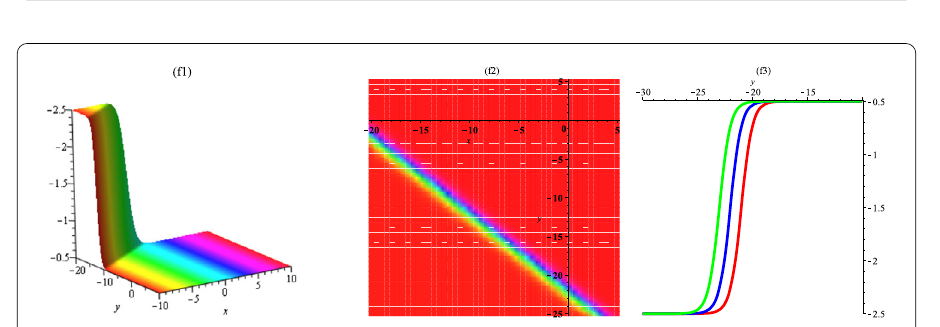
Figure 5 For solution of (2) w , c i = 1, t = 1, z = 0, (f1) 3D plot (f2) density plot and (f3) 2D plot with spaces x = –3,0,3